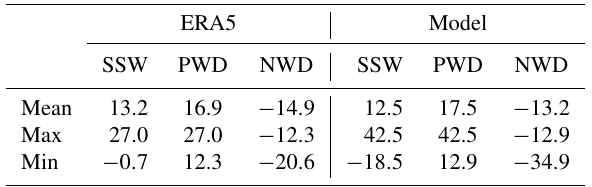
Table 1. Statistics of the accumulated wave driving anomaly, (cid:80) F (cid:48) Tabulated are the mean, maximum, and minimum of (cid:80) F (cid:48) day) prior to the onset of the various events. The threshold (cid:80) F (cid:48) for PWD and NWDs is ± 12 . 9d for the model and ± 12 . 3d for